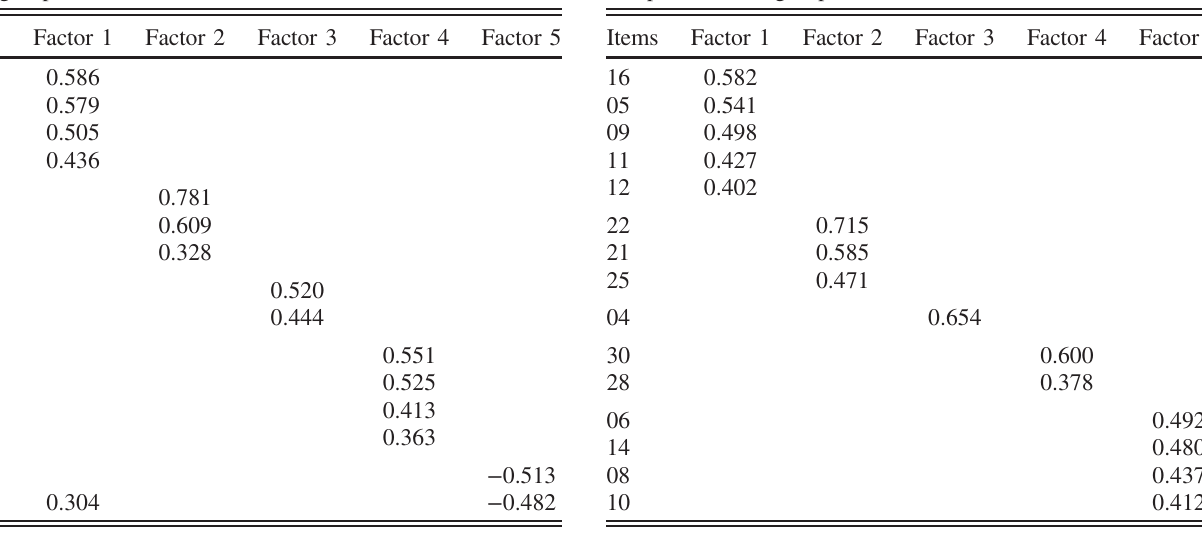
TABLE XIII. Finalized five-factor loadings for group B. Loadings less than 0.25 have been suppressed. EFA involved approximately half of the section 1 students. These loadings represent results after a filtering of the original 30 items and a comparison with group